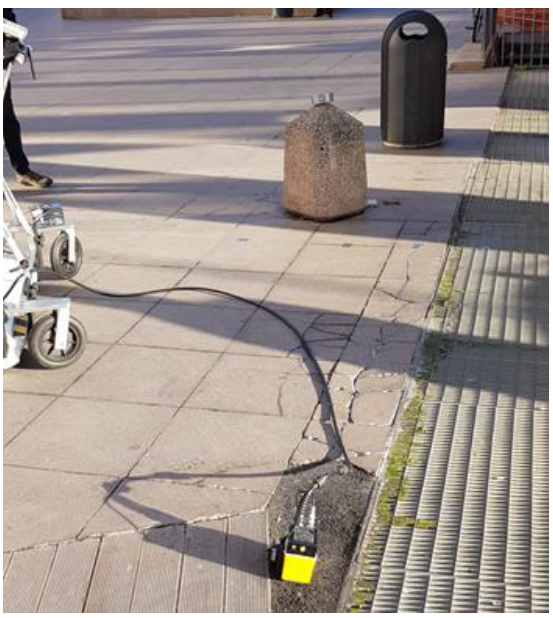
Figure 3. A photograph of the exploited GPR antenna.